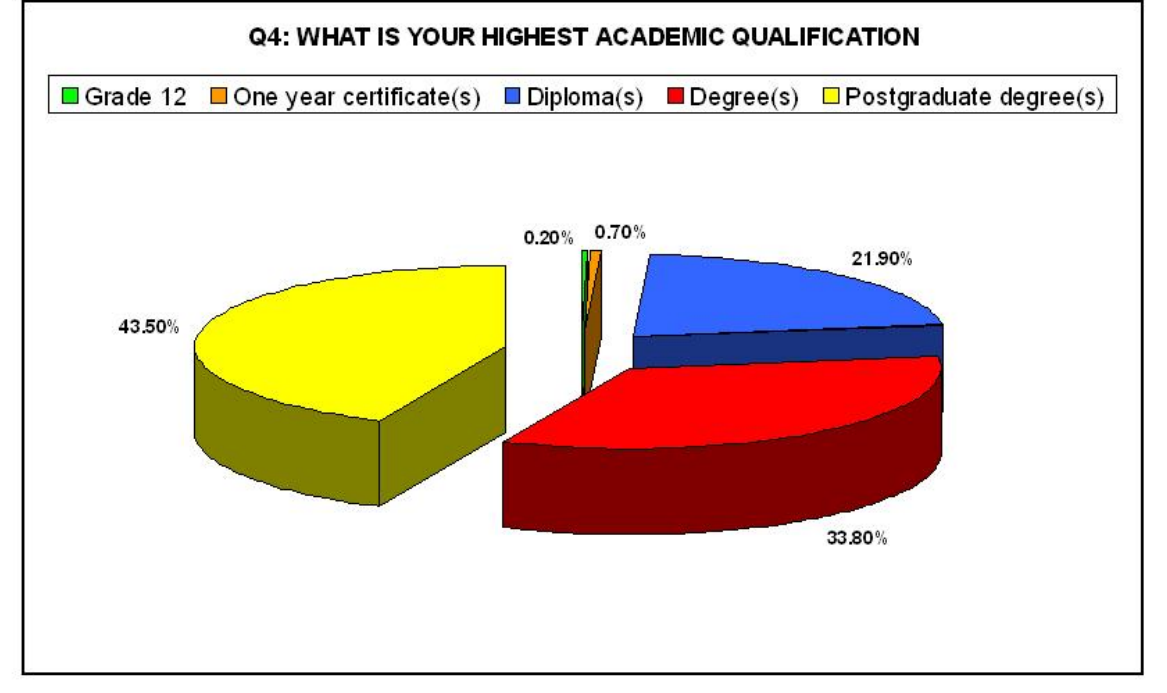
Figure 3 Representation of the responses to Question 5 of the